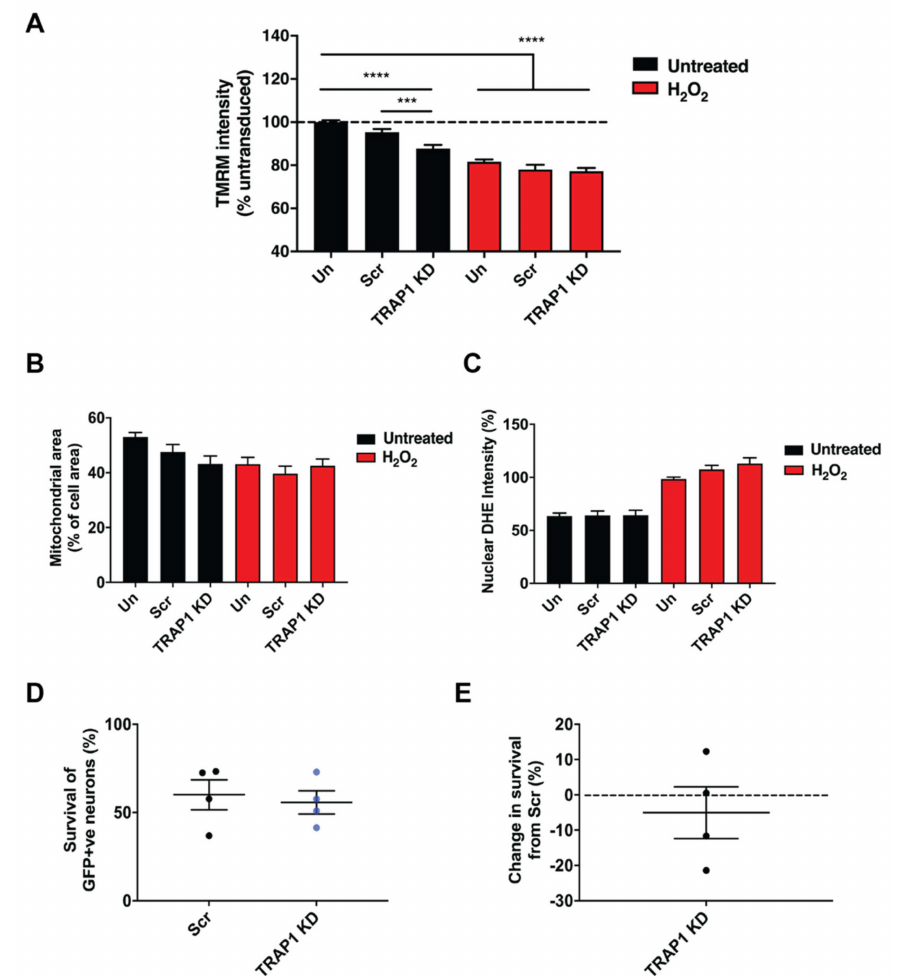
Figure 3. TRAP1 knockdown reduces motor neuron mitochondrial membrane potential but does not exacerbate H 2 O 2 –induced loss of mitochondrial membrane potential or increased ROS and cell death. ( A ) Quantification of lentivirally treated primary motor neuron cultures for TMRM intensity and ( B ) mitochondrial area after 500 µ m H 2 O 2 treatment for 30 min, Scr: Scrambled shRNA; TRAP1 KD: TRAP1 knockdown shRNA. n = 3–6, 40–237 neurons. ( C ) Quantification of DHE intensity measurements in lentivirally treated primary motor neurons after 500 µ m H 2 O 2 treatment for 30 min. n = 3–4, 73–203 neurons. Quantification of percentage survival compared to untransduced cultures ( D ) and percentage change in survival from cultures treated with scrambled lentiviral construct ( E ) in GFP–positive neurons exposed to 100 µ m H 2 O 2 for 24 h. n = 4. *** p ≤ 0.001, **** p ≤